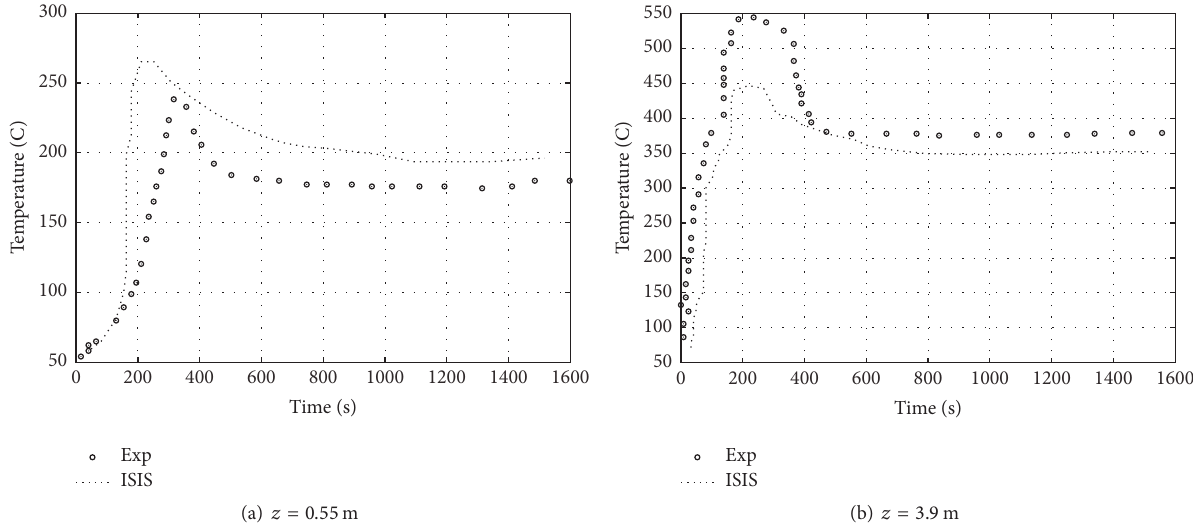
Figure 6: Temperatures at the center domain above the fire source with different height.